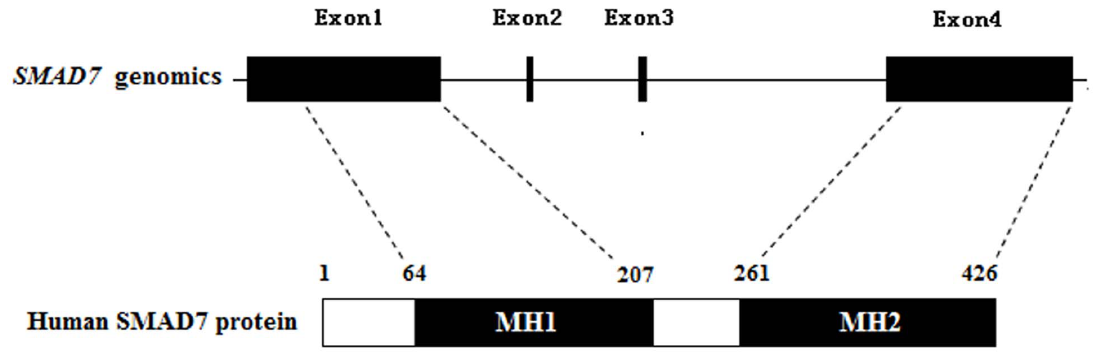
Figure 1. Schematic of SMAD7 and the encoded protein. MH1, MAD homology 1 domain; MH2, MAD homology 2 domain.